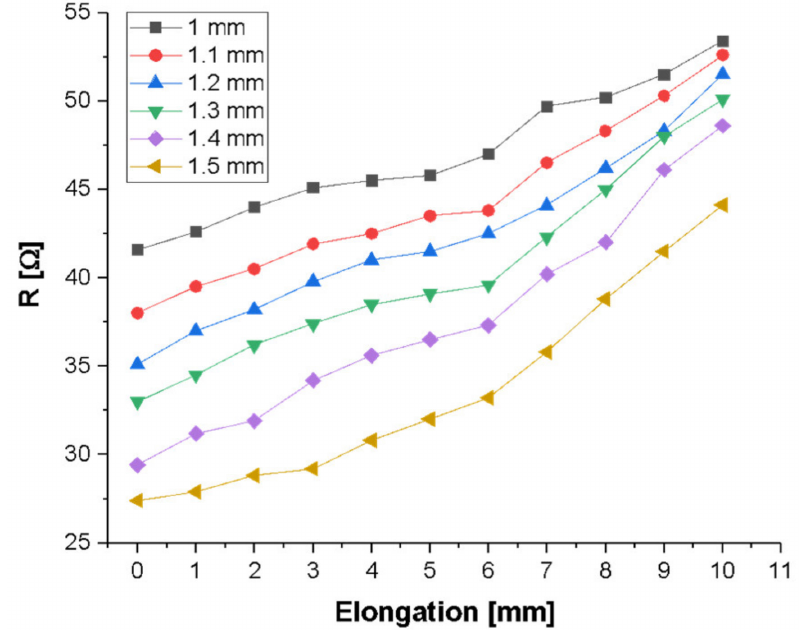
Figure A8. Resistance variation of each pattern of the Inkron IPC-603X screen-printed ink on the DelStar EU94DS substrate according to the